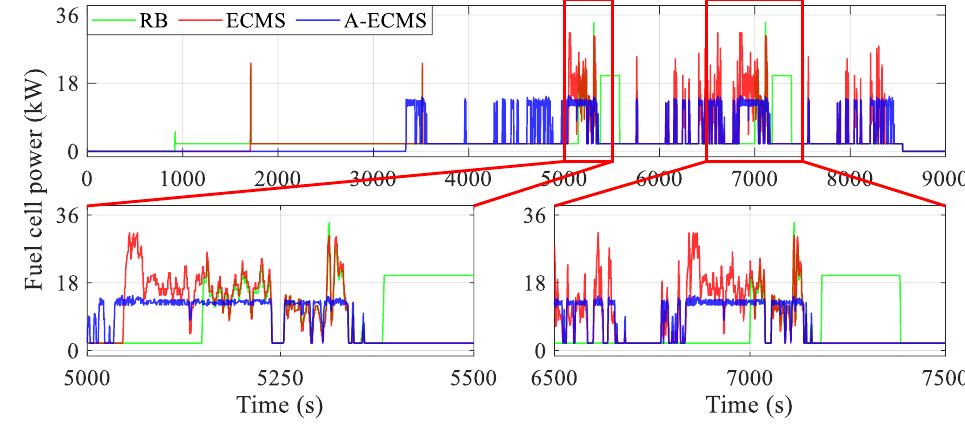
Figure 10. Curves of fuel cell system power using different methods.